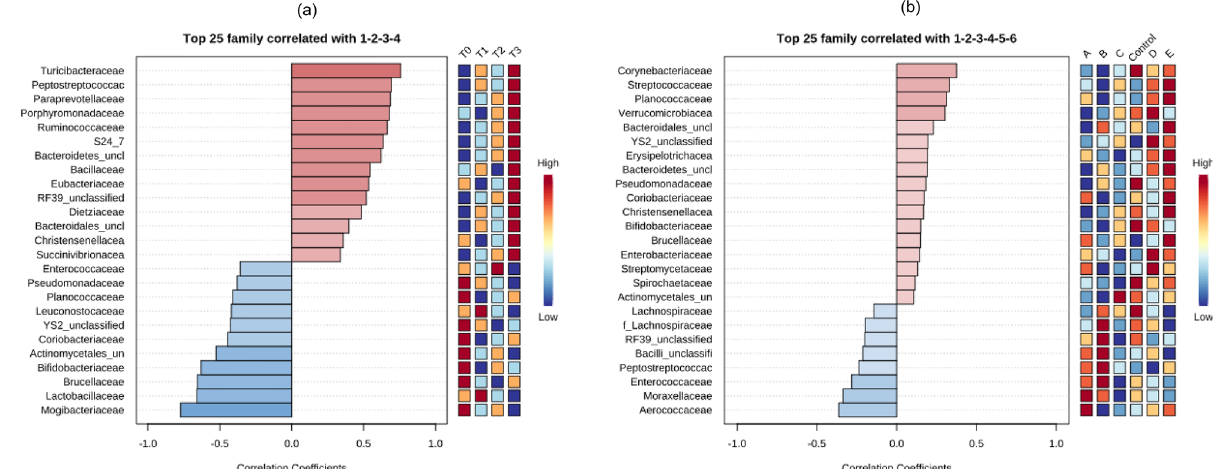
Figure 7. Plot from LEfSe analysis indicating enriched bacterial families associated either with positive (pink) or negative (light blue) correlations in cattle fecal samples as affected by ( a ) experimental administration periods and ( b ) probiotic